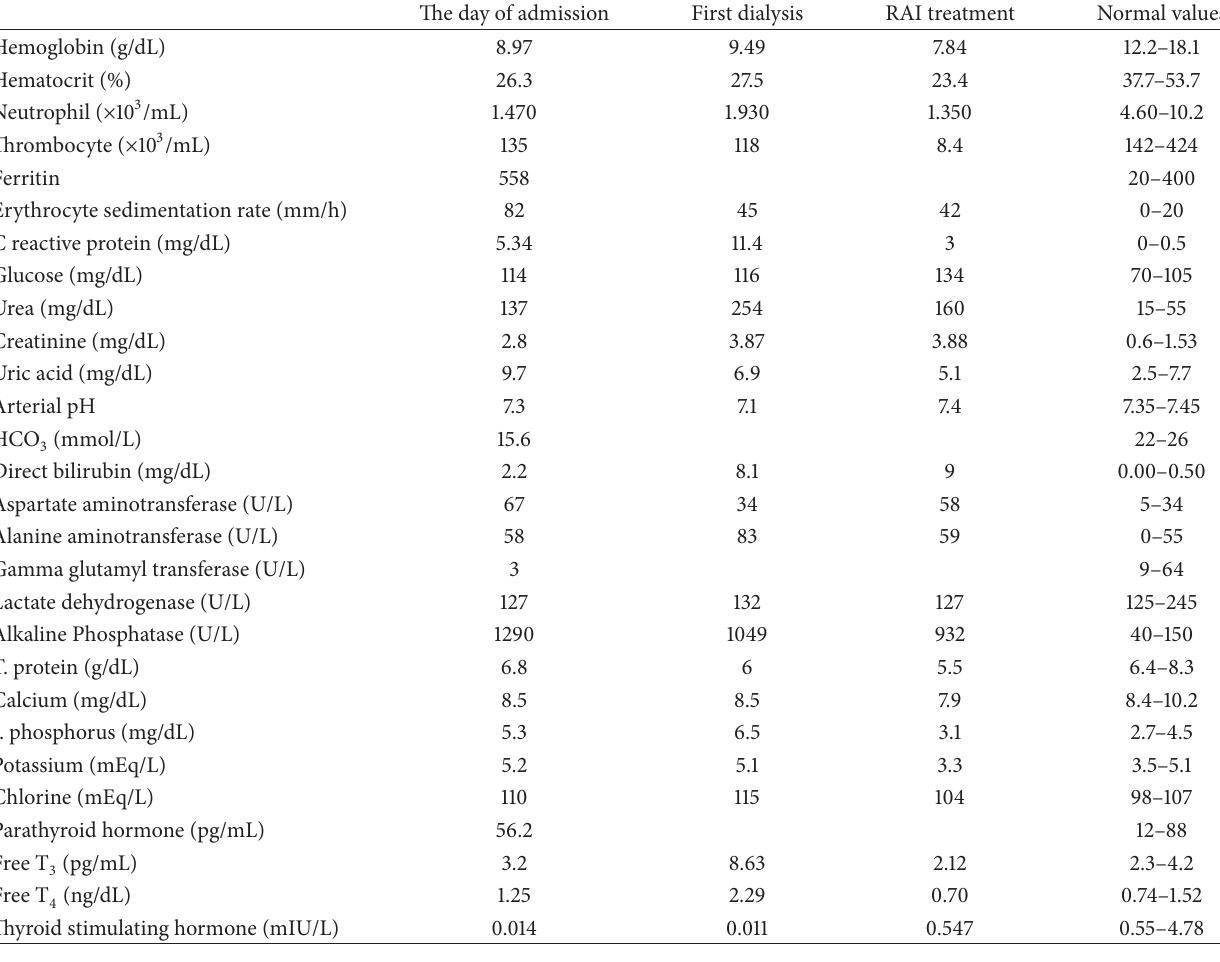
Table 1: Laboratory findings of the case.